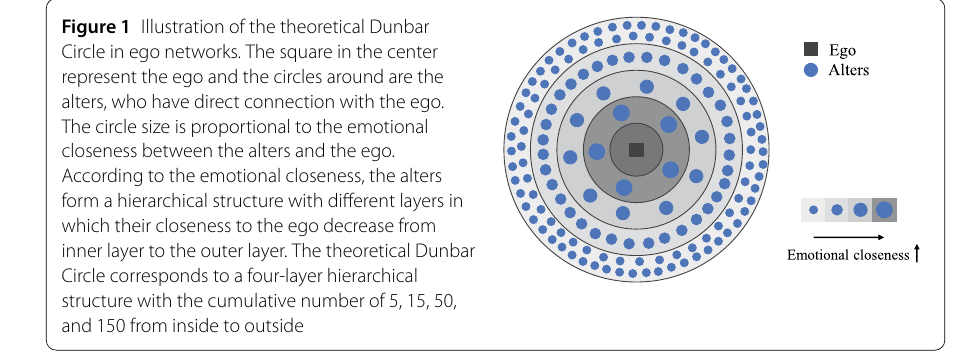
Table 1 Statistical descriptions of SVEIN and SVCN. k denotes the degree of users in the network Degree Weighted degree N f mean